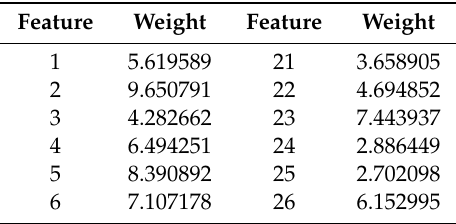
Table 12. Weight of each